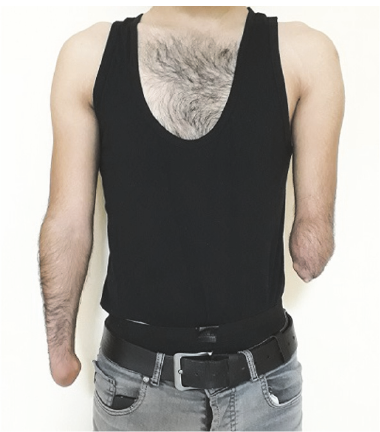
Figure 1: Clinical photograph of the patient with bilateral upper limb meromelia.